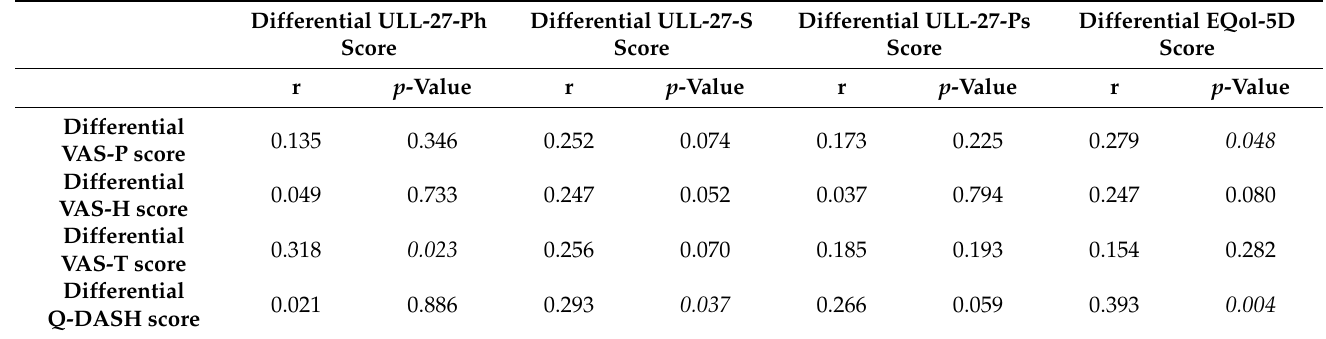
Table 2. Relationship between the different dimensions of HRQoL and pain, heaviness, tightness and performance of the upper limb on the affected side, using Pearson’s